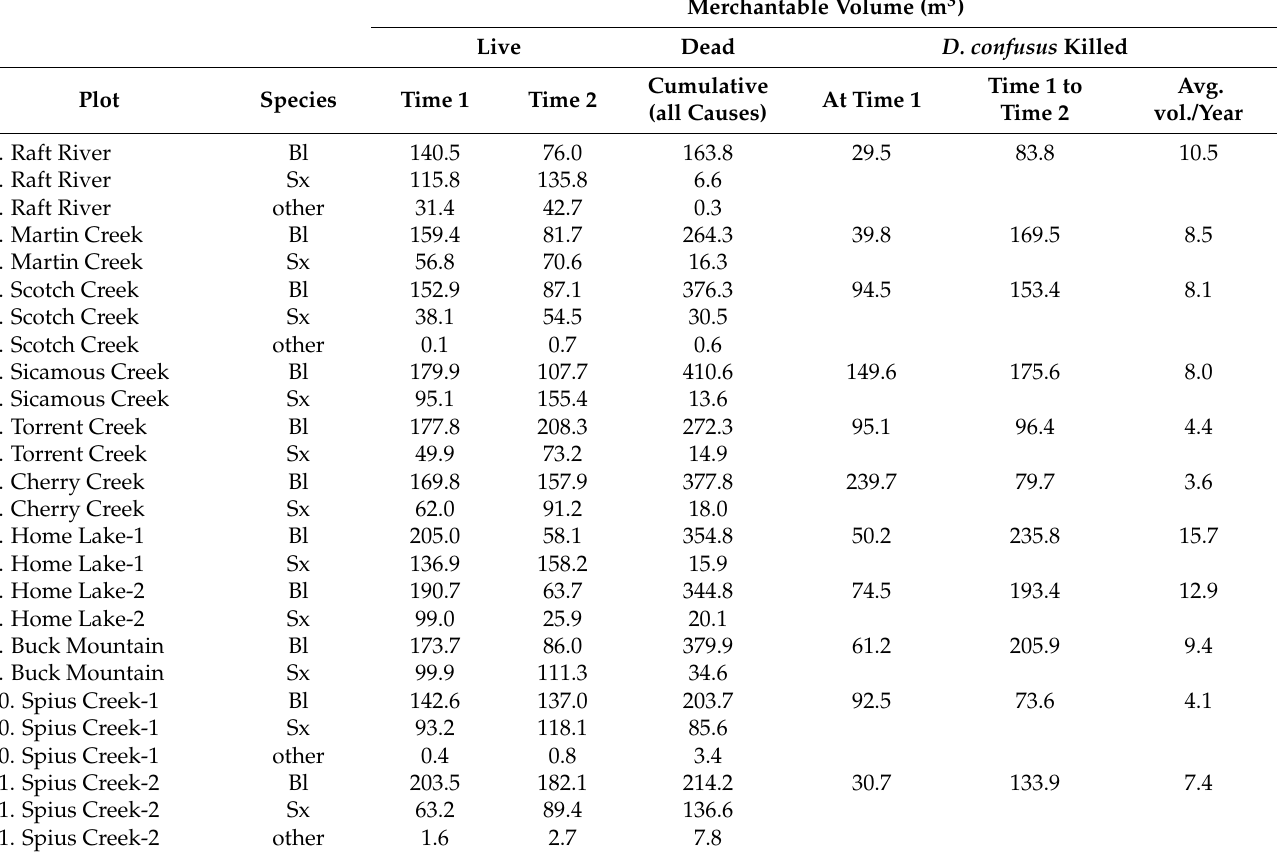
Table 7. An estimate of the merchantable volume of live subalpine fir, spruce, and other species in plots at the time of establishment (Time 1) and final assessment (Time 2). Additionally, an estimate of all dead volume (from all causes) in each plot, and volume killed by D. confusus at Time 1; between Time 1 and Time 2; and the average annual mortality (m 3 ) from D. confusus between Time 1 and Time 2.